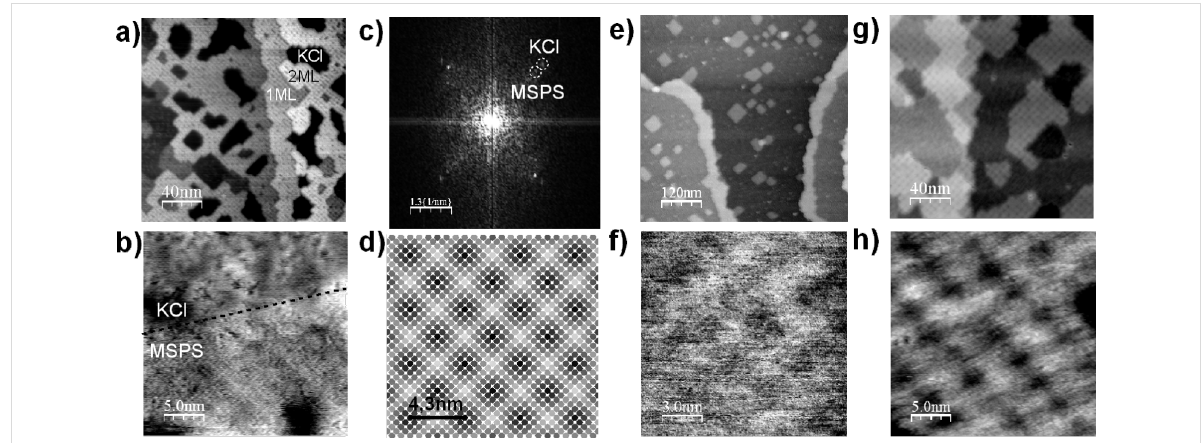
Figure 3: (a) Topography image of ≈ 1 ML of MSPS adsorbed on KCl ( Δ f = − 75 Hz, A 0 = 7 nm); (b) shows a close up view on an MSPS island boundary with both, the MSPS and the KCl substrate imaged with molecular resolution ( Δ f = − 17 Hz, A 0 = 5 nm). (c) Fourier transform of the image displayed in (b), two quadratic and parallel lattices are observed; MSPS has a slightly larger lattice constant. (d) simulation of a Moiré pattern obtained by superimposing the lattices of KCl and MSPS. (e) Topography image of ≈ 0.3 ML MSPS on RbCl ( Δ f = − 60 Hz, A 0 = 7 nm) with a close up view of an MSPS island in (f) ( Δ f = − 230 Hz, A 0 = 7 nm). (g) Topography image of ≈ 0.5 ML MSPS on KBr ( Δ f = − 25 Hz, A 0 = 10 nm) with a close up view on an MSPS island in (f) ( Δ f = − 30 Hz, A 0 = 10 nm).